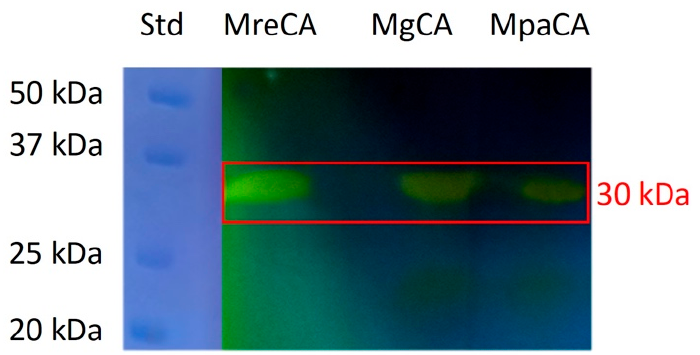
Figure 1. SDS-PAGE showing results regarding MpaCA heterologous expression in bacterial cells and further purification from corresponding extracts. A total of 1 mM IPTG was used to induce MpaCA biosynthesis. Overexpressed MpaCA is visible in the lane indicated with “+IPTG”, migrat- ing with an apparent molecular mass of about 30 kDa. The enzyme is not present in lane “-IPTG”, which shows the bacterial lysate supernatant before isopropyl- β -D-thiogalactopyranoside induc- tion. A bacterial extract containing soluble MpaCA was resolved on a HisTrap FF column to yield a pure, homogeneous preparation of the fungal enzyme (Lane “Purified MpaCA”). The red box rep- resents MpaCA migrating with an experimental molecular mass of 30 kDa. Protonographic analysis (Figure 2) was used to determine whether purified recombi- nant MpaCA could catalyze the CO 2 hydration reaction (Figures 1 and 2). Two homologous CAs, namely MgCA and MreCA, which are encoded from the genome of M. globosa and M. restricta , respectively, were used as positive controls. As expected, the protonogram in all cases exhibited yellow bands migrating at a molecular mass of about 30 kDa (Figure 2), thus demonstrating a CO 2 hydratase activity for all fungal CAs, including MpaCA.